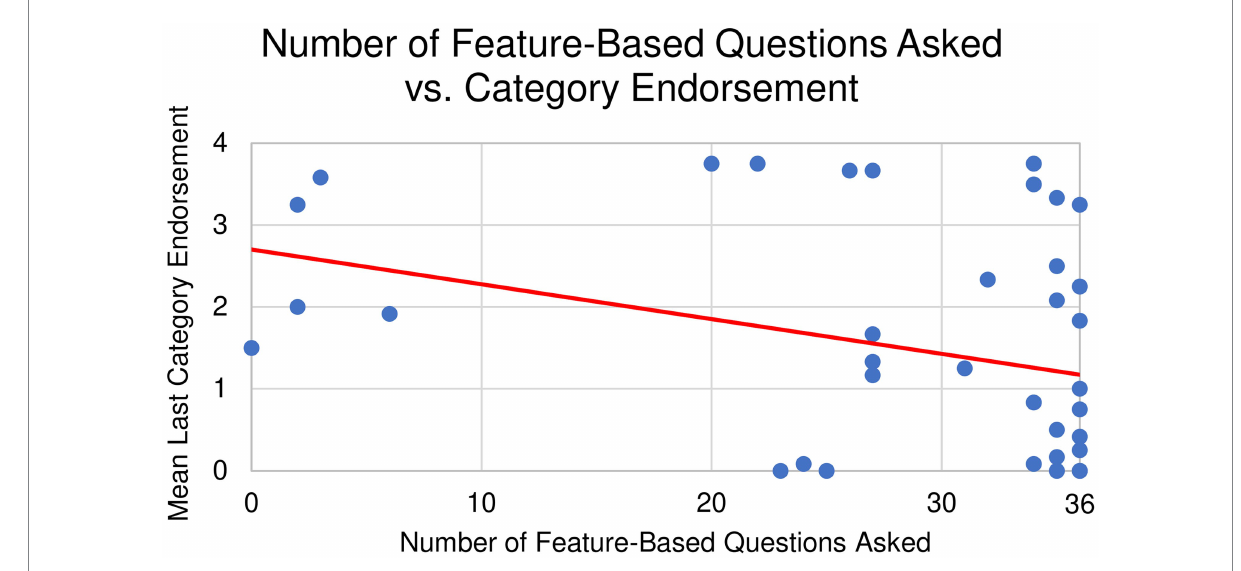
FIGURE 8 Bivariate correlation between feature-based questions and category